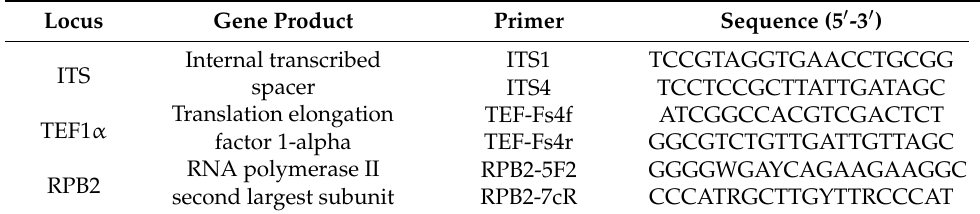
ITS1 TCCGTAGGTGAACCTGCGG ITS4